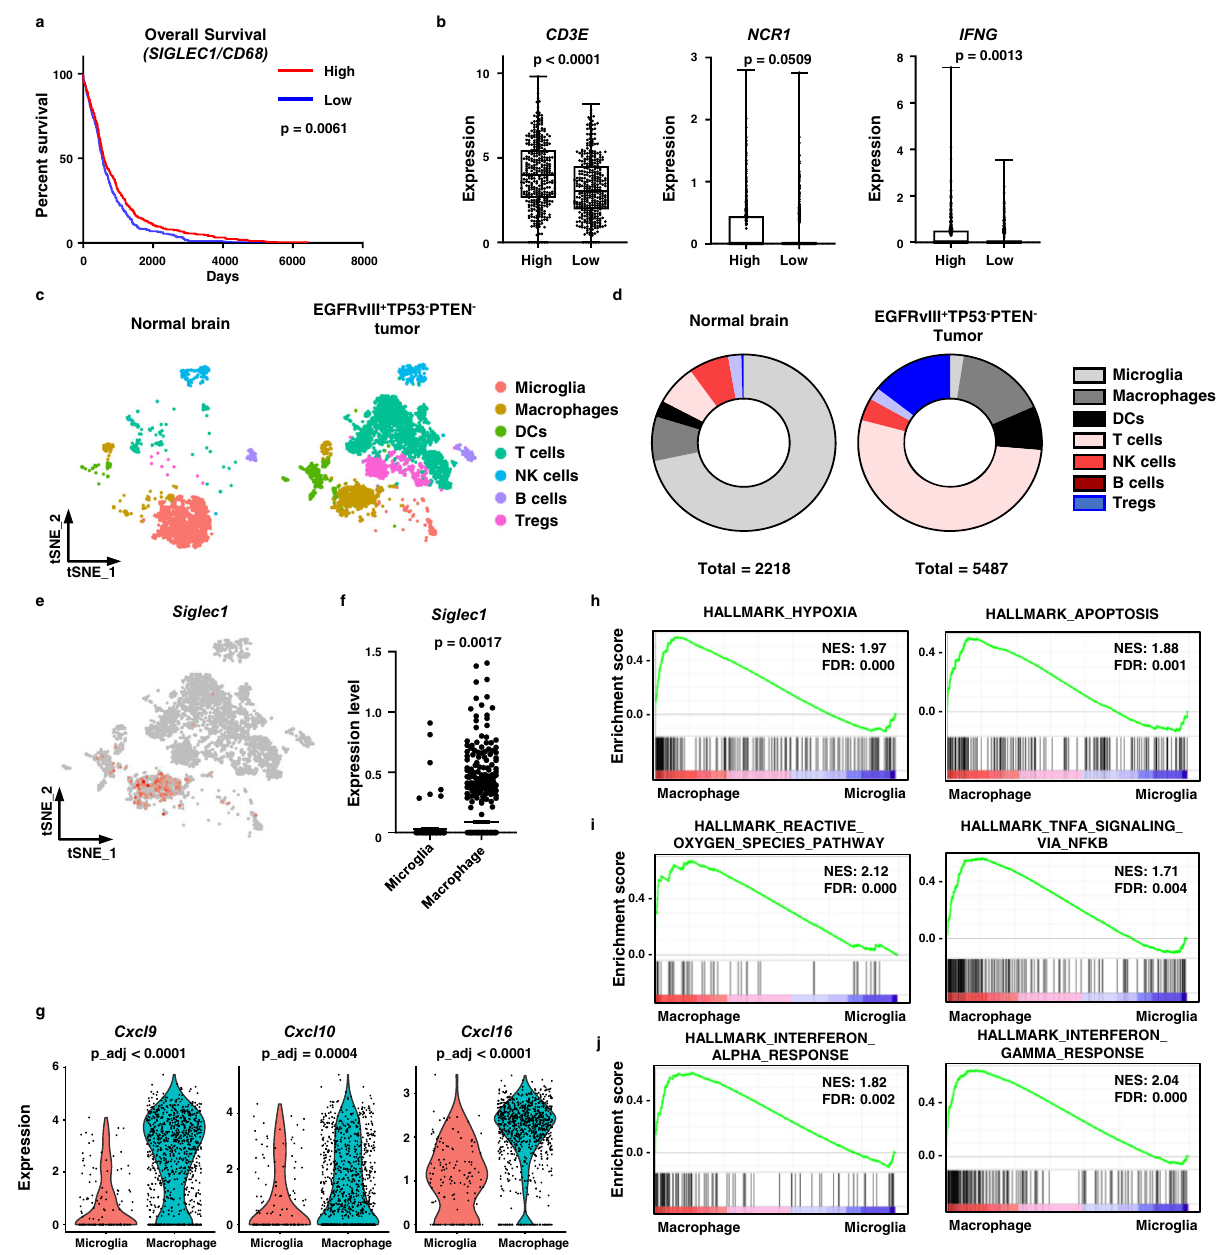
Fig. 1 | CD169 is a marker of in fl ammatory macrophages in human and mouse gliomas. a , b We analyzed human data from The Cancer Genome Atlas (TCGA) Glioblastoma (TCGA-GBM) and Low Grade Glioma (TCGA-LGG) databases ( n =694). Patients were grouped by their gene expression levels compared to the median. a Overall survival and b proin fl ammatory gene ( CD3E , NCR1 , and IFNG ) expression in patients grouped by high ( n =347) or low ( n =347) SIGLEC1 expres- sion in tumor-in fi ltrating macrophages ( SIGLEC1 / CD68 , median=0.632). Differ- enceinsurvivalwasmeasuredbylog-rank(Mantel-Cox)test.The p valuesforgene expression were calculated by unpaired two-tailed t -test. Box plots denote the median, 25 – 75th percentiles, and minimum and maximum values. c – j Mouse GBM was induced by deletion of transformation related protein p53 ( Tp53 ) and phos- phatase and tensin homolog ( Pten ) and by expression of epidermal growth factor receptor variant III ( EgfrvIII ) in the brain. CD45 + immune cells were sorted from